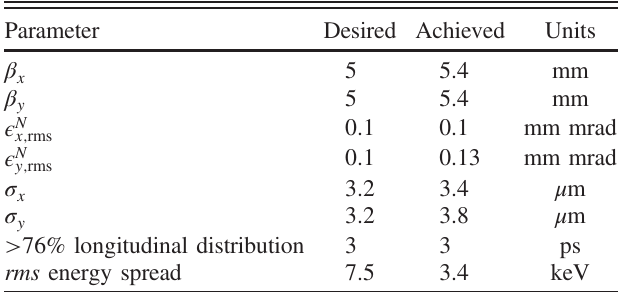
TABLE XII. Select properties of the electron beam parameters, both desired and achieved, at the